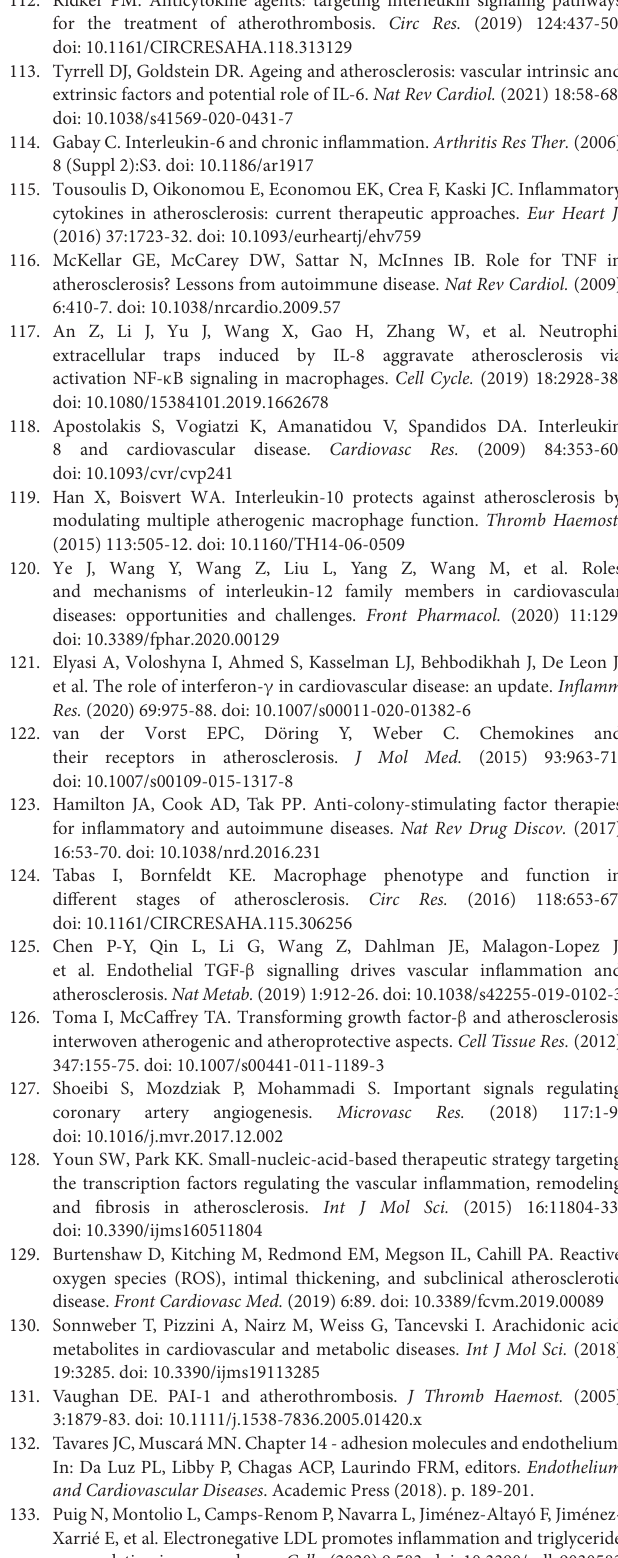
beta(1) modulates oxidatively modified LDL-induced expression